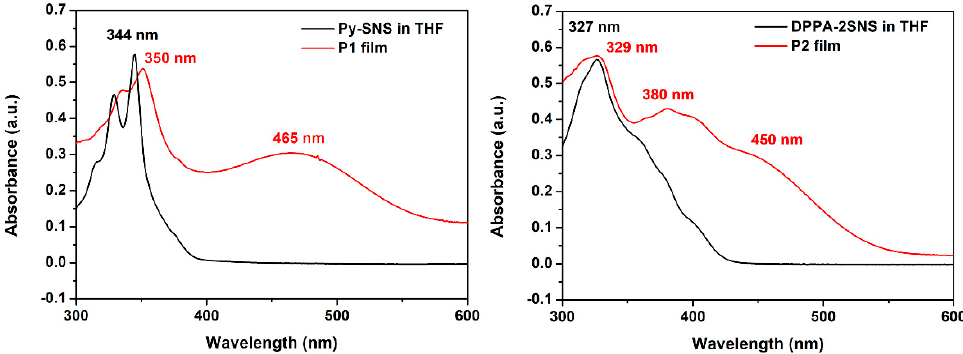
Figure 6. UV-vis absorption spectra of Py-SNS and DPPA-2SNS in THF (ca. 1 × 10 − 5 M) and their electrodeposited films on ITO-glass. electrodeposited films on